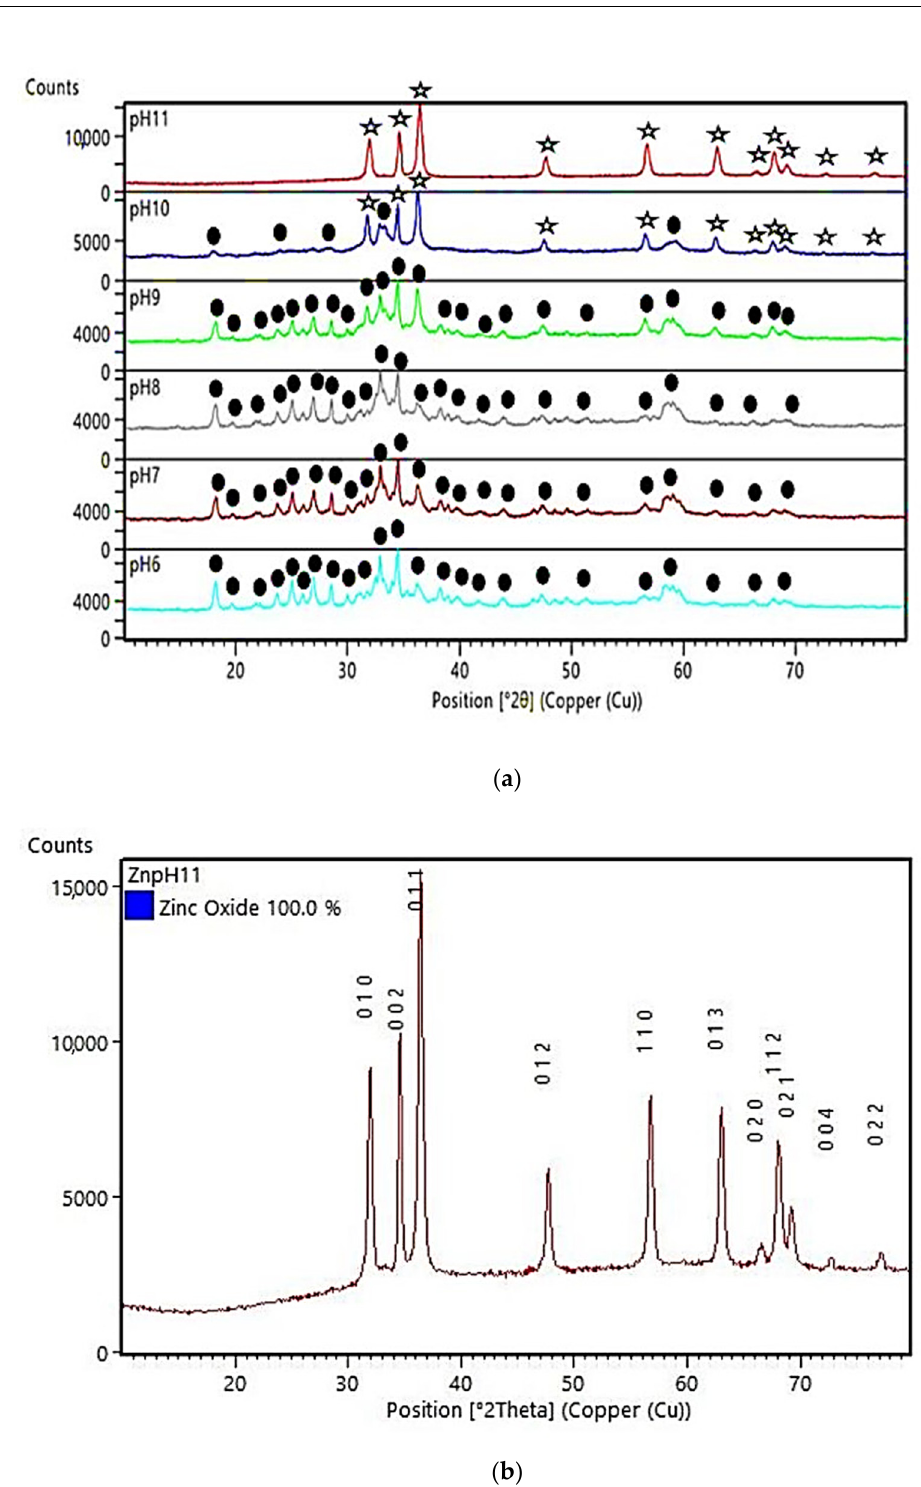
Figure 1. ( a ) XRD spectra of particles formed in the in situ synthesis of ZnO on ND-colored Batik fabric at pH 6–pH 11, : ZnO, : Zn 5 (OH) 8 (NO 3 ) 2 ·2H 2 O (Pentazinc Octahydroxide), ( b ) XRD spectra of JCPDS data.